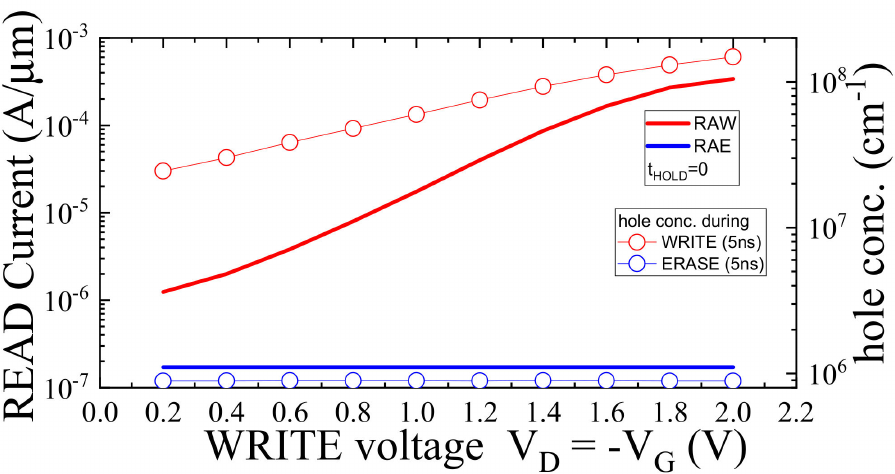
Figure 5. ( left axis ) READ after WRITE (RAW) and READ after ERASE (RAE) currents (t HOLD = 0, V G = − 2 V, V D = 0.1 V) and ( right axis ) the integrated hole concentration during WRITE and ERASE operations as function of the WRITE voltage V D = − V G (V G = V D = 0 during ERASE). The hole concentration is integrated in the channel and in the body raised region ( − L /2 ≤ x ≤ L